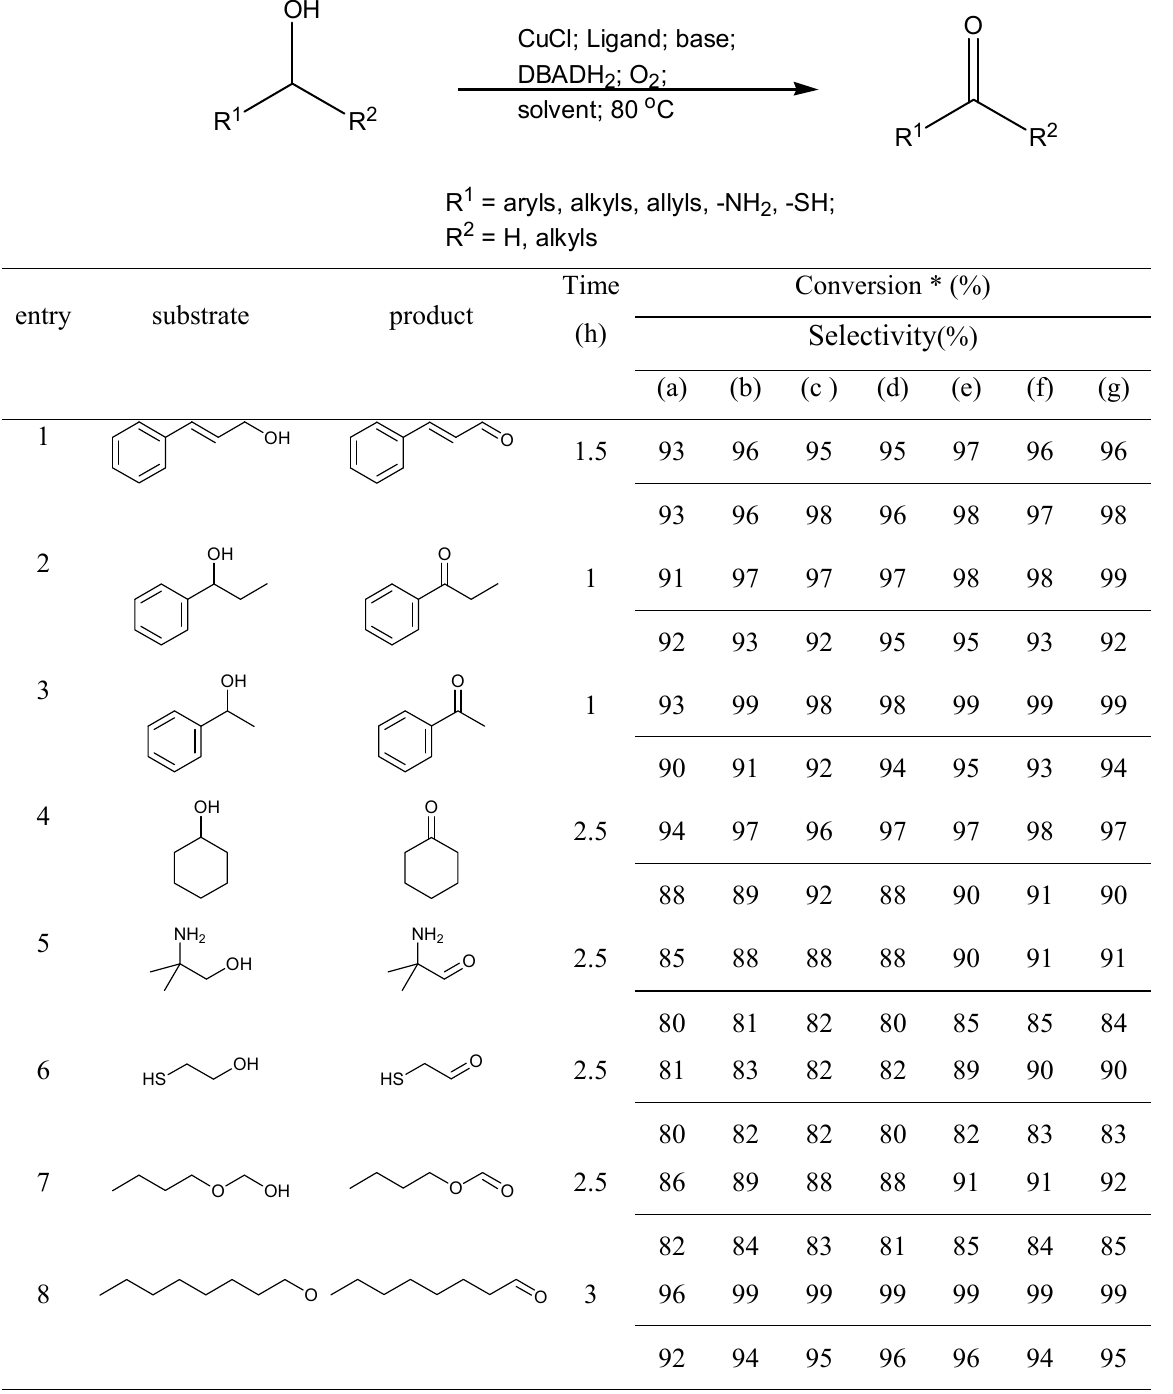
Table 1. Oxidation of alcohols catalyzed by Cu-bisisoquinoline catalytic